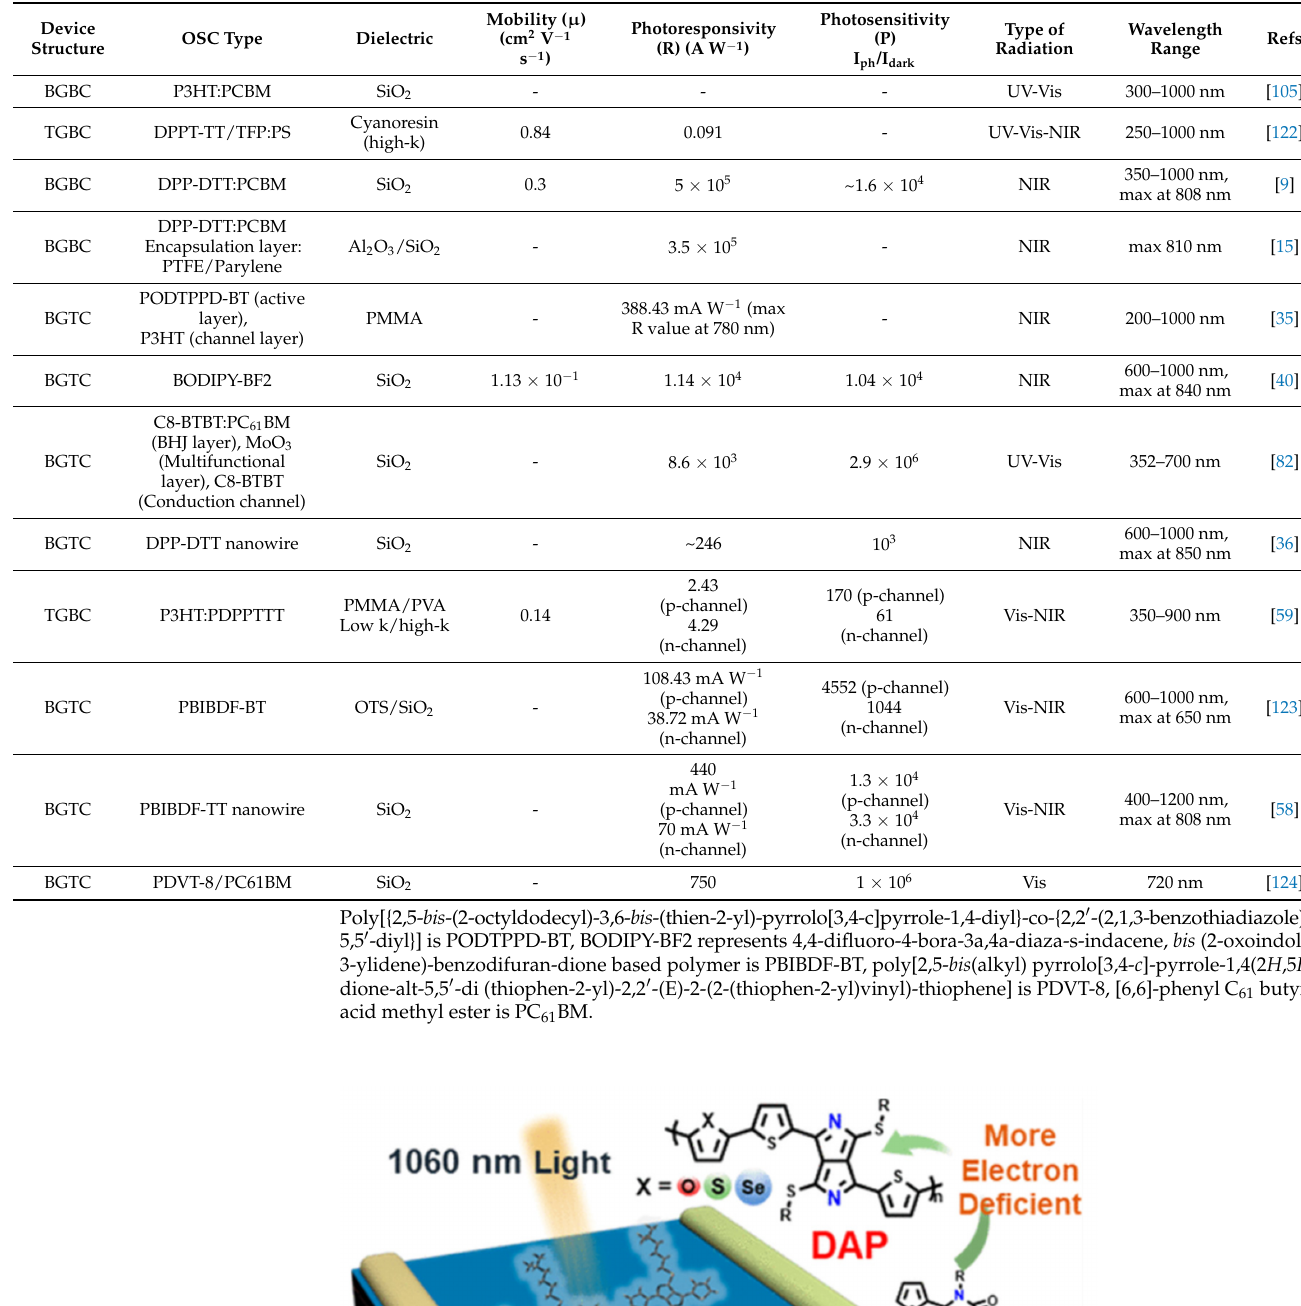
Table 3. Solution-processed OPTs with the device performance parameters.